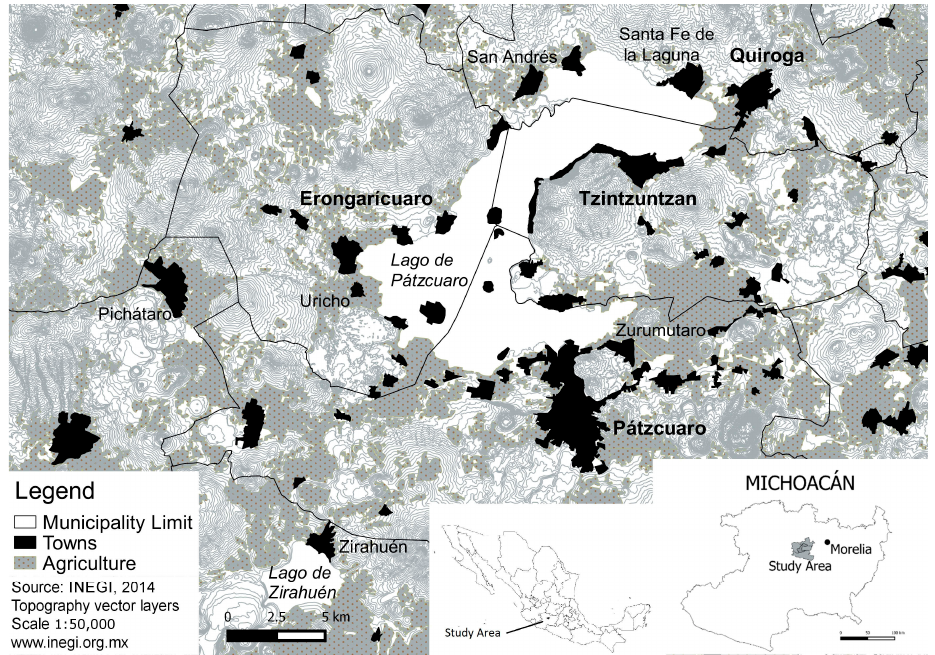
Figure 2. Map of the study area.